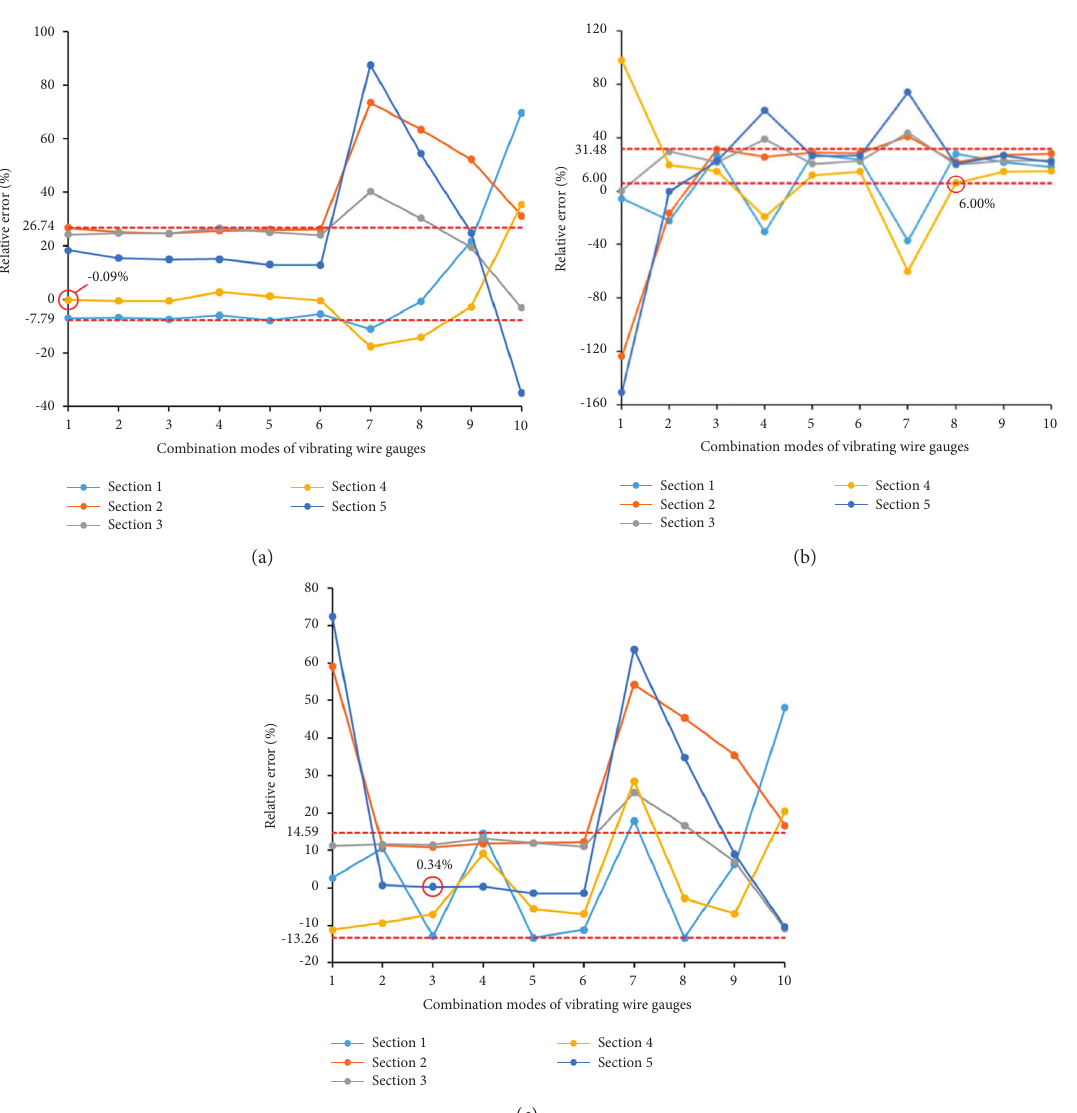
Figure 12: Comparison of results between algorithm and FEM: (a) maximum axial stress σ shear stress τ max